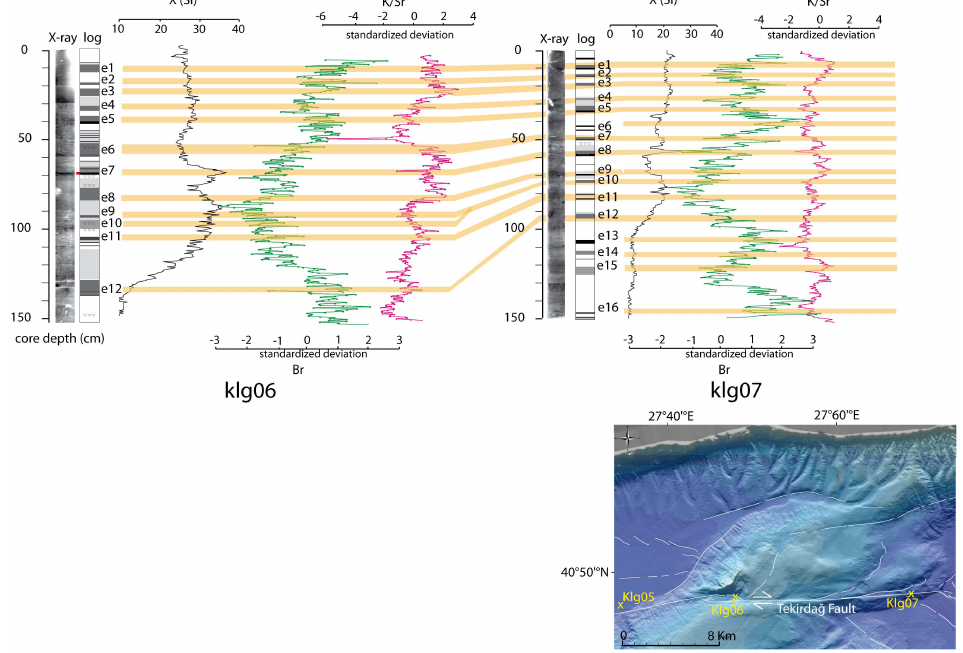
Fig. 9. Core correlation between Klg06 and Klg07 using X-ray, magnetic susceptibility, bromine and K/Sr ratio. Increase Sr at the base of turbidites suggests allochthonous input. On the opposite, increase in K might reflect higher illite content in the upper clayey-silt sublayer. Localisation of the cores is indicated on the inset